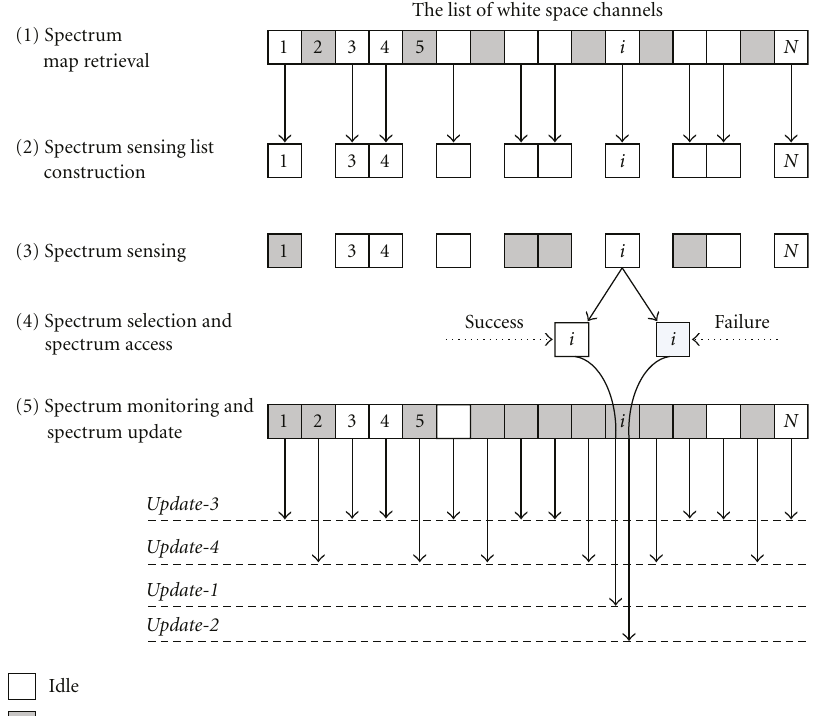
Figure 3: An example of a channel selection procedure with the proposed